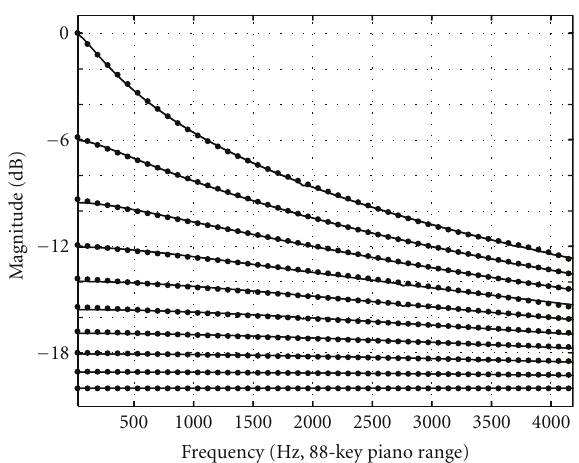
Figure 9: FBAM gain (solid) and its polynomial approximation (dotted). β = 0 . 1 (bottom) ··· β = 0 . 9